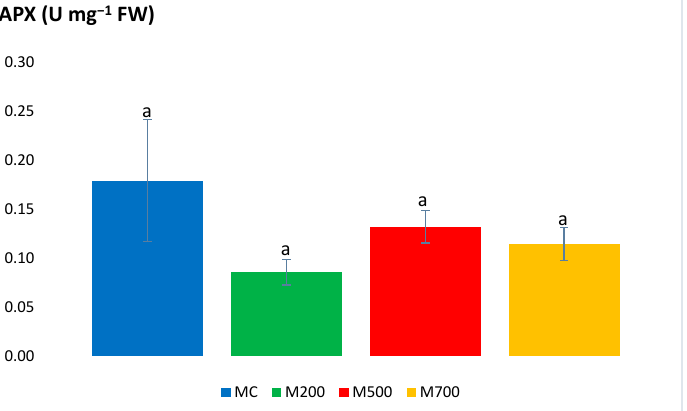
Figure 1. Ascorbate peroxidase (APX) activity in the leaves of Mis-B cultivar cultivated in soils with gradient T.E. concentrations (MC, M200, M500, M700). Values are presented as mean ± SE. Different letters refer to significant differences between plants (Tukey HSD test, n = 6, p ≤ 0.05).